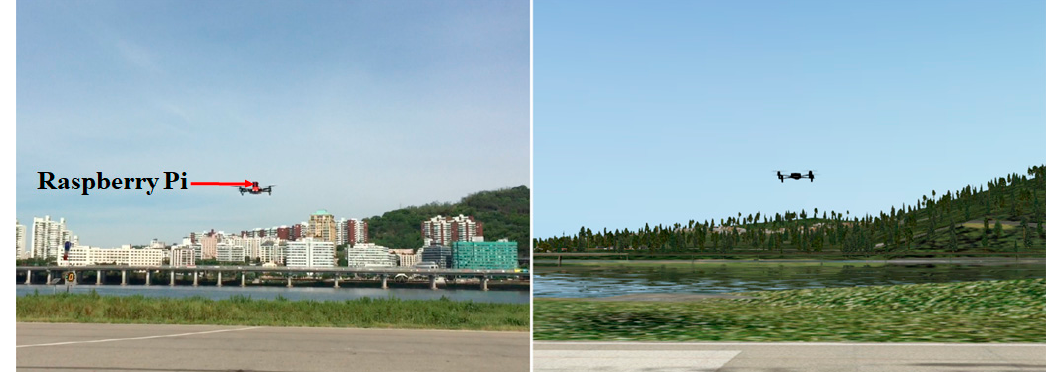
Figure 34. Picture of the real ( left ) part and the visualization part ( right ) during the vertical take ‐ off and landing of the quadcopter.